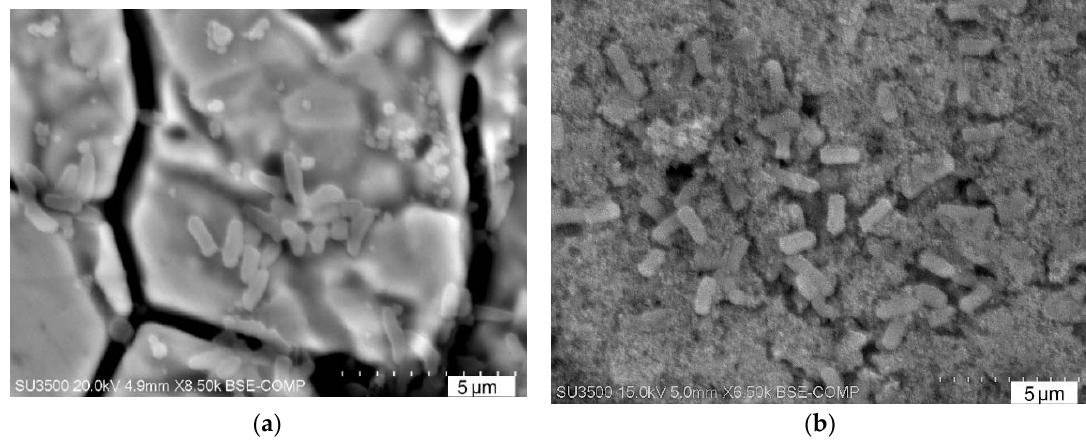
Figure 9. SEM images of Bacillus amyloliquefaciens colonisation of ( a ) kraft lignin and ( b ) the kraft lignin/silica system.